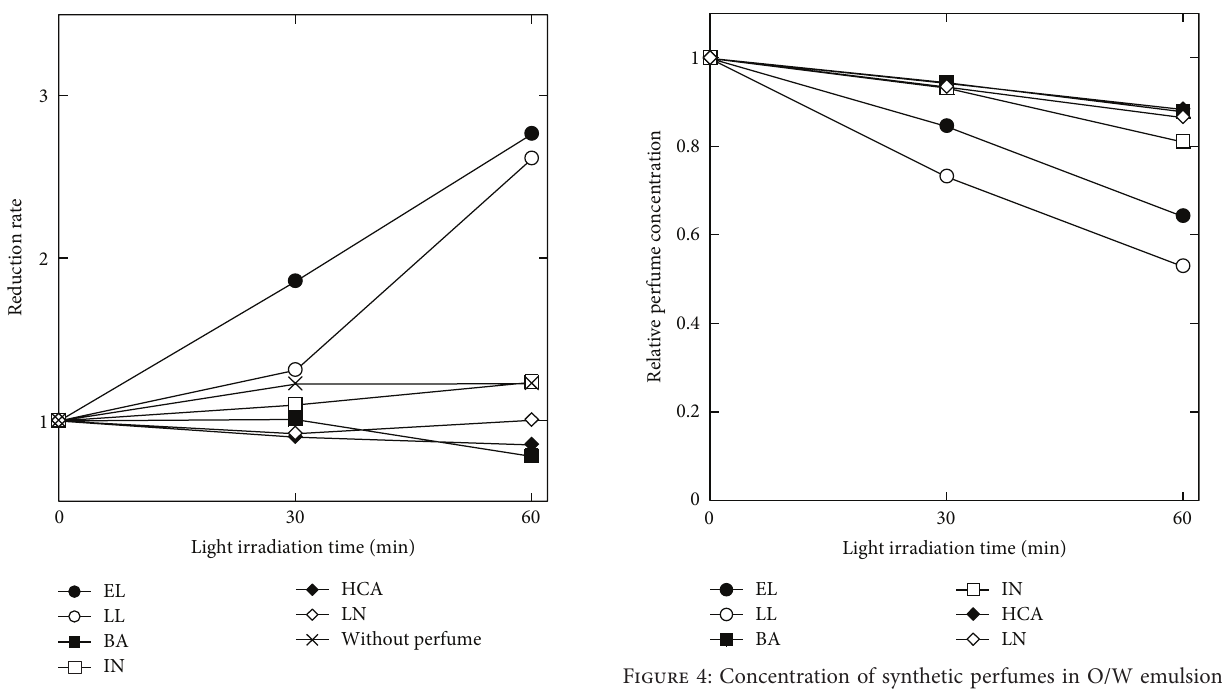
Figure 3: Change in the reduction rate of absorbance at 700 nm of O/W emulsion with light irradiation time.